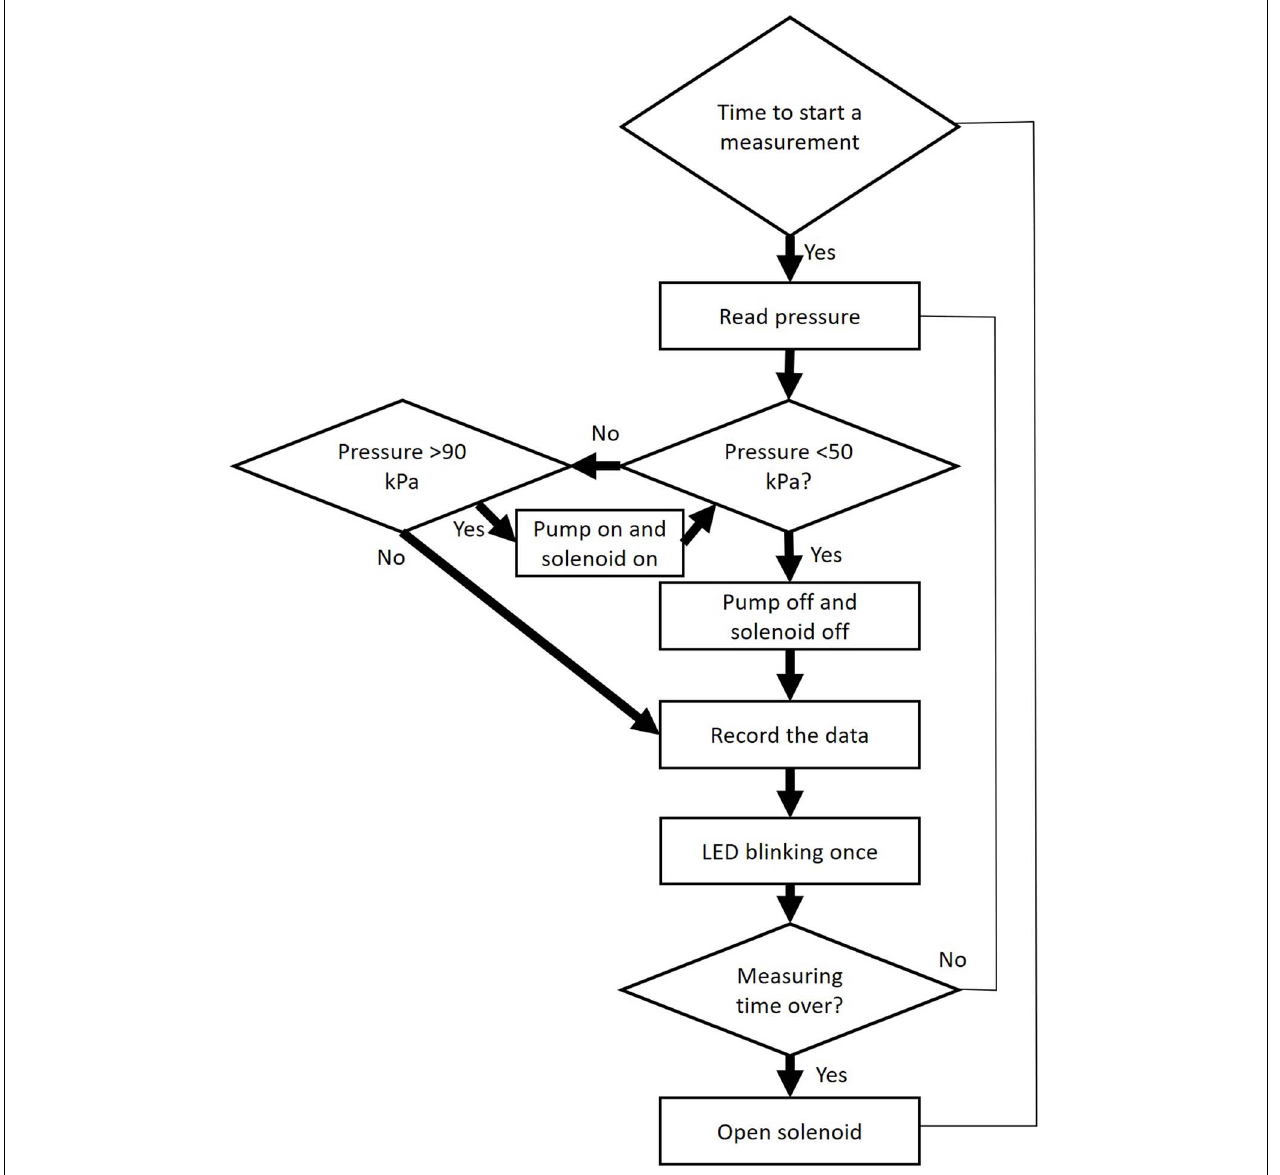
FIGURE 3 | Workflow of operational steps when using the Pneumatron in automated mode. This workflow is repeated many times within a pre-selected measuring interval ( ≥ 15 s).